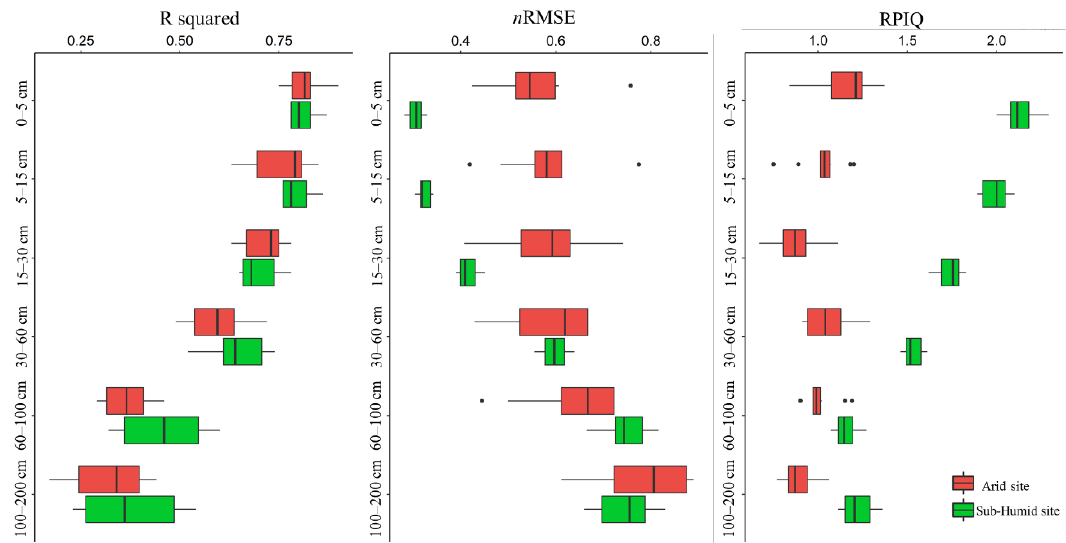
Figure 7. Comparison of prediction power of ML models for SOC content at six standard depths in two regions.